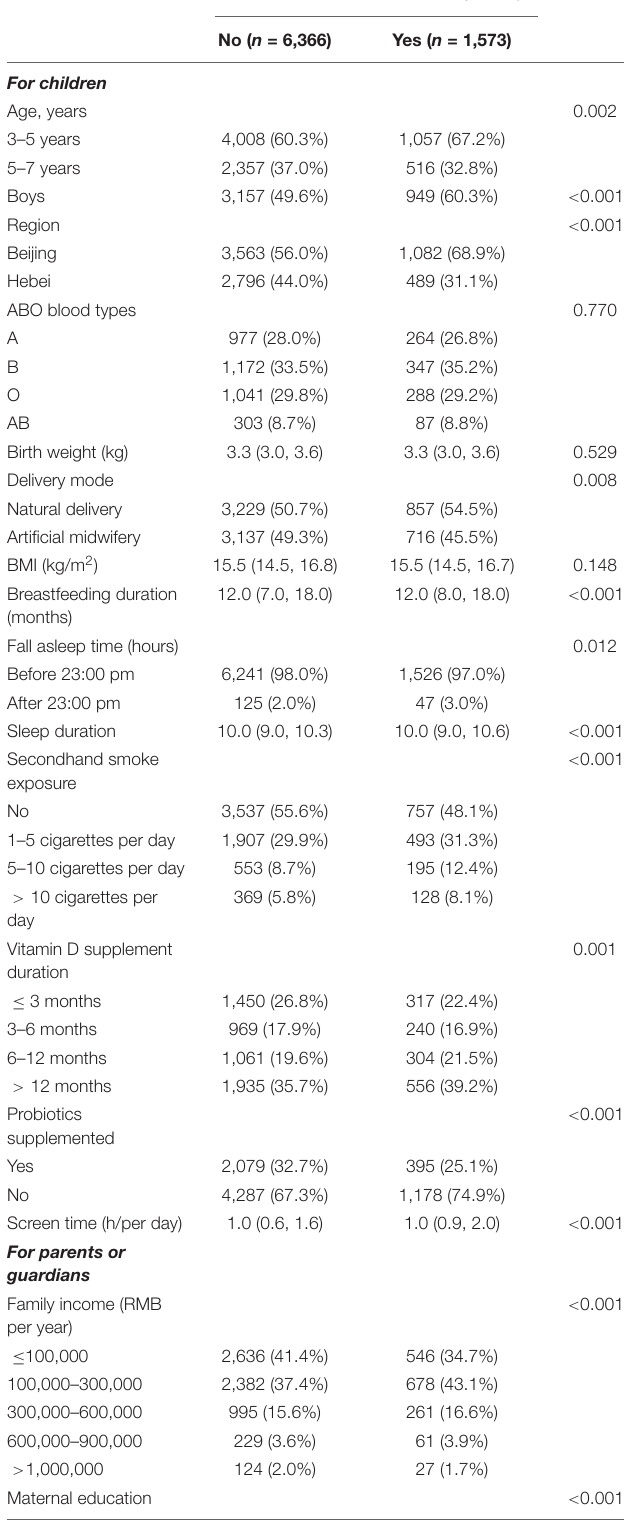
TABLE 1 | Baseline characteristics of study participants in this